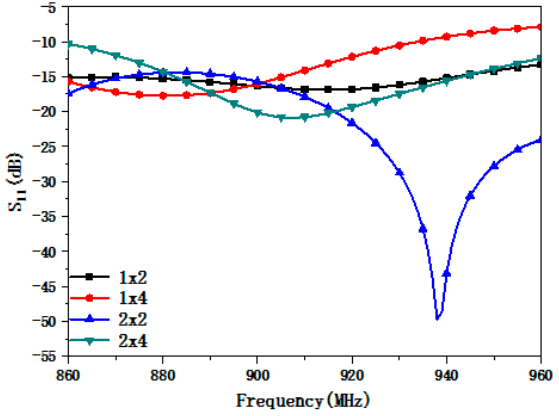
Figure 24. Simulated reflection coefficients of the array antenna.